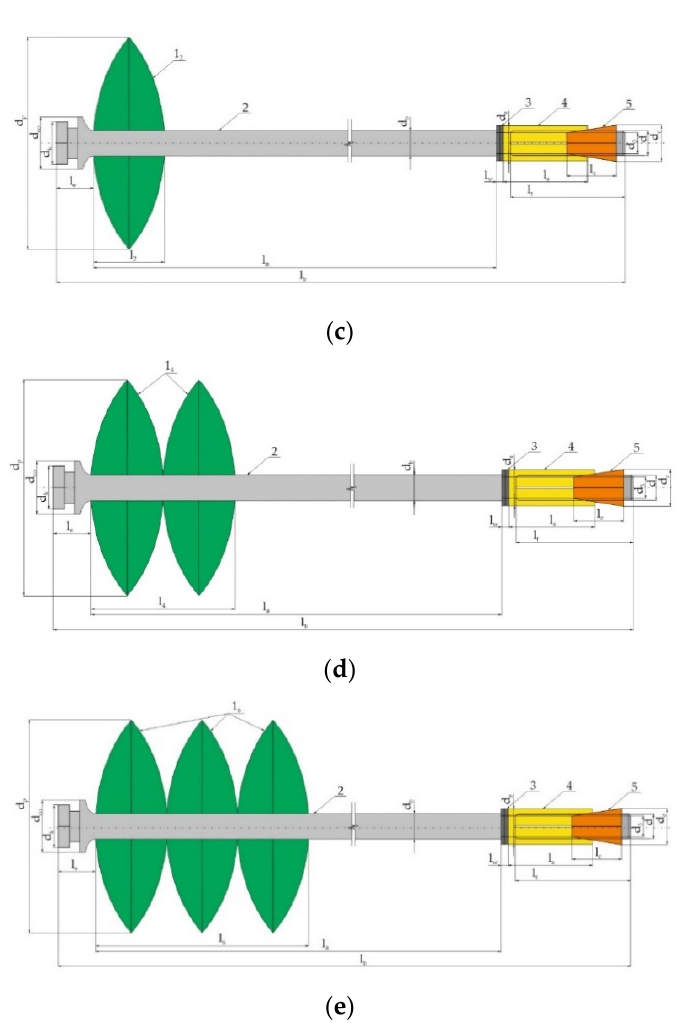
Figure 10. Configuration of the connection of the bolt rod with bearing plates: ( a ) square shaped flat; ( b ) round profiled dome; ( c ) two round profiled domes; ( d ) four round profiled domes; ( e ) six round profiled domes; 1 0 -square bearing plate, sheet metal thickness 6 mm; 1 1 -round, profiled dome bearing plate, 25 mm thick; 1 2 -two round, profiled dome bearing plates with a total thickness of 50 mm; 1 4 -four round profiled dome bearing plates with a total thickness of 100 mm; 1 6 -six profiled dome bearing plates with a total thickness of 150 mm; 2-smooth bolt rod; 3-two rounded bearing plates, constituting the limitation of the mechanical sleeve; 4-mechanical sleeve; 5-conical spreader; d p –bearing plate diameter (150 mm); d co -diameter of the swollen bolt rod end (36 mm); d k -hexagonal bolt rod end (30 mm); d b -rod diameter (18.3 mm); d s -diameter of a rounded washers (25 mm); d 3 -thread core diameter (14.93 mm); d-thread diameter (17.3 mm); d c -diameter of the conical spreader (25.4 mm); l e -the length of the bolt rod end with a variable diameter, larger than the diameter of the bolt rod (33 mm); l 0 -height of the square bearing plate (6 mm); l 1 -height of the round, profiled dome bearing plate (25 mm); l 2 -height of two round, profiled dome bearing plates (50 mm); l 4 -height of four profiled dome bearing plates (100 mm); l 6 -height of six profiled dome bearing plates (150 mm); l a -rod length with a diameter 18.3 mm (1478 mm); l b -total length of the bolt rod (1.6 m); l w -length of the smooth part of the bolt rod (5 mm); l t -thread length (84 mm); l s -sleeve length (58.85 mm); l c -length of a conical spreader (35 mm).